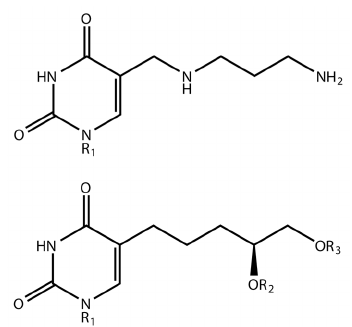
Figure 1. Structures of the hypermodified thymine derivatives in ΦW-14 (top) and SP-15 (bottom) phage DNAs. In both cases, R1 indicates the deoxyribosyl moiety; while in the latter case, R2/R3 represent glucosyl and phosphoglucuronolactoneresidues.